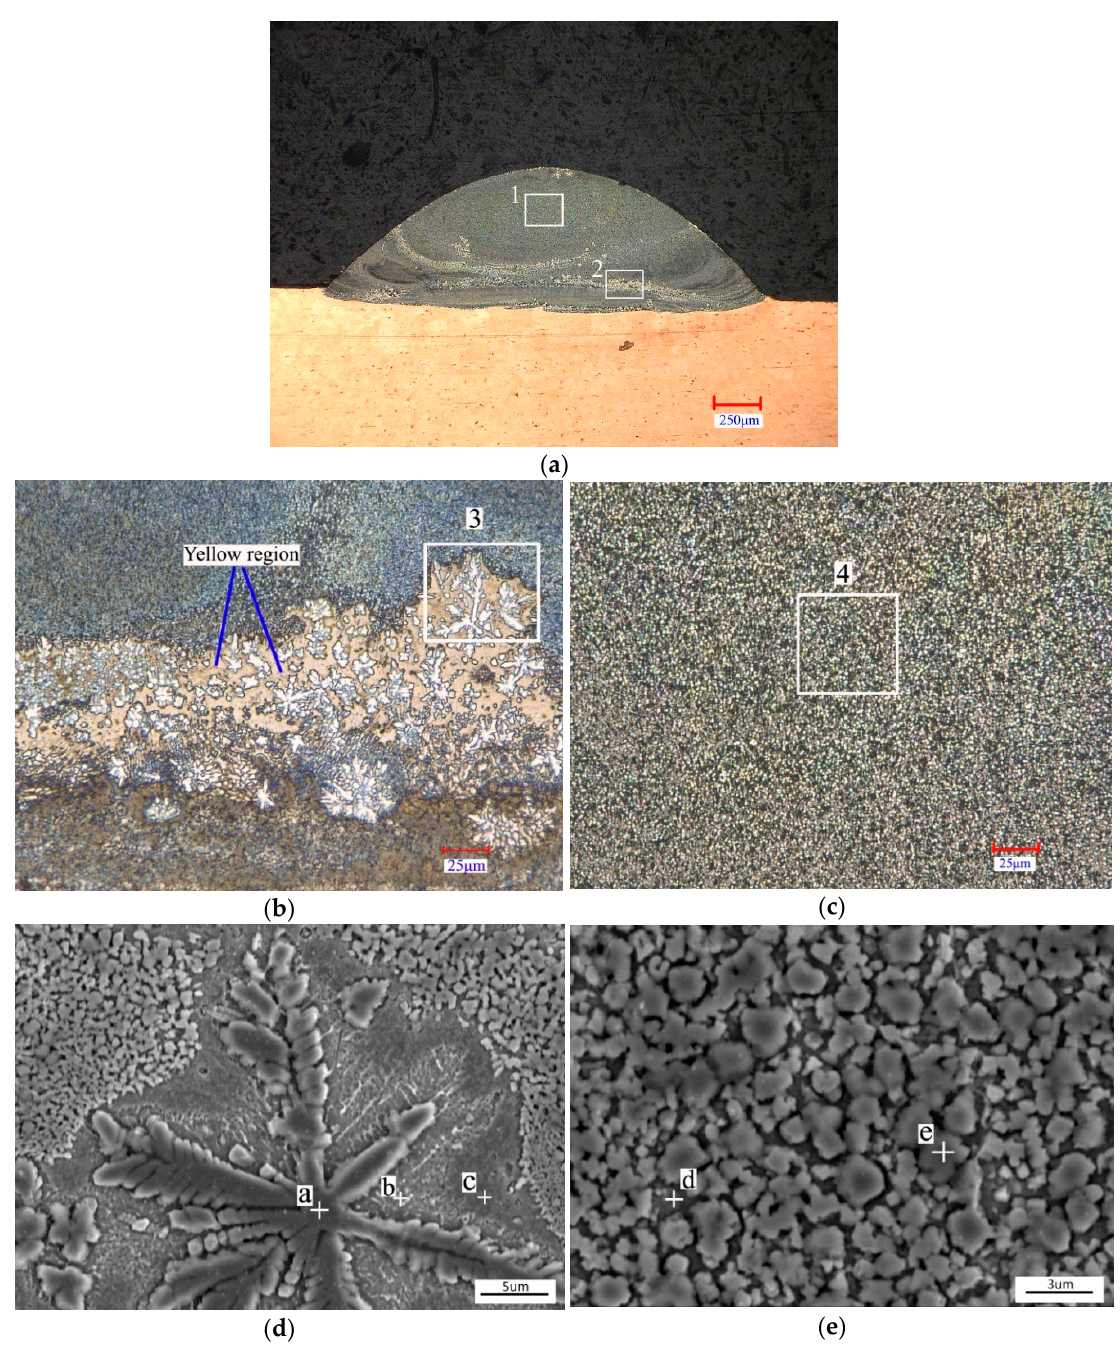
Figure 5. Cross-sectional optical microscopy (OM) images and scanning electron microscopy (SEM) images of Coating 1: ( a ) OM image of Coating 1; ( b ) Amplification of region 2 in image ( a ); ( c ) Amplification of region 1 in image ( a ); ( d ) Amplification of region 3 in image ( b ); ( e ) Amplification of region 4 in image ( c ).